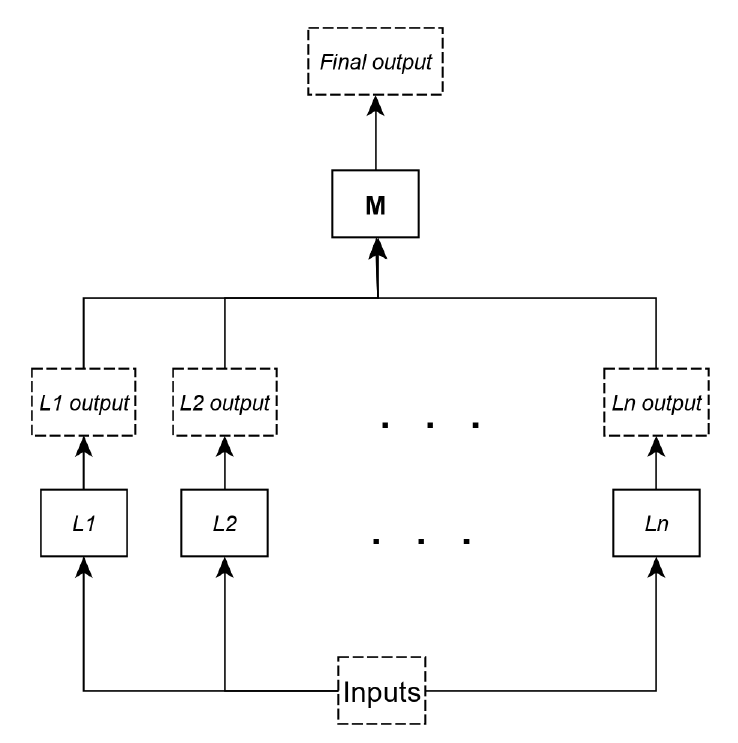
Figure 4. Overview of a stacking ensemble learning